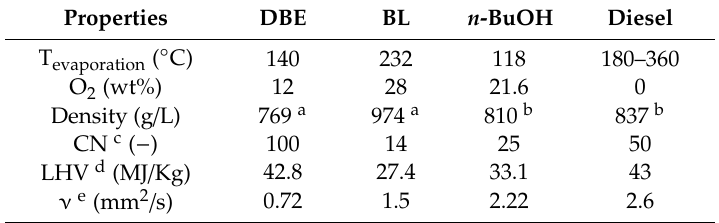
Table 8. Overview of biomass resources available from the literature [13,21,61].